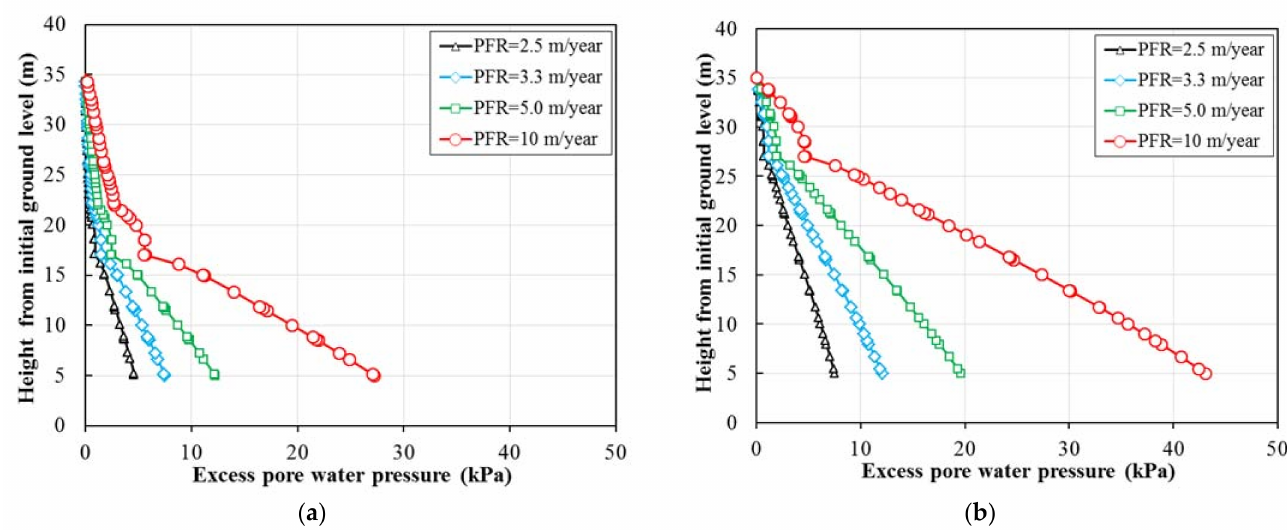
Figure 10. Excess pore water pressure after the last consolidation phase C5 with respect to the pond filling rates ( PFR ) at sections: ( a ) A–A’ and ( b ) B–B’ (defined in Figure